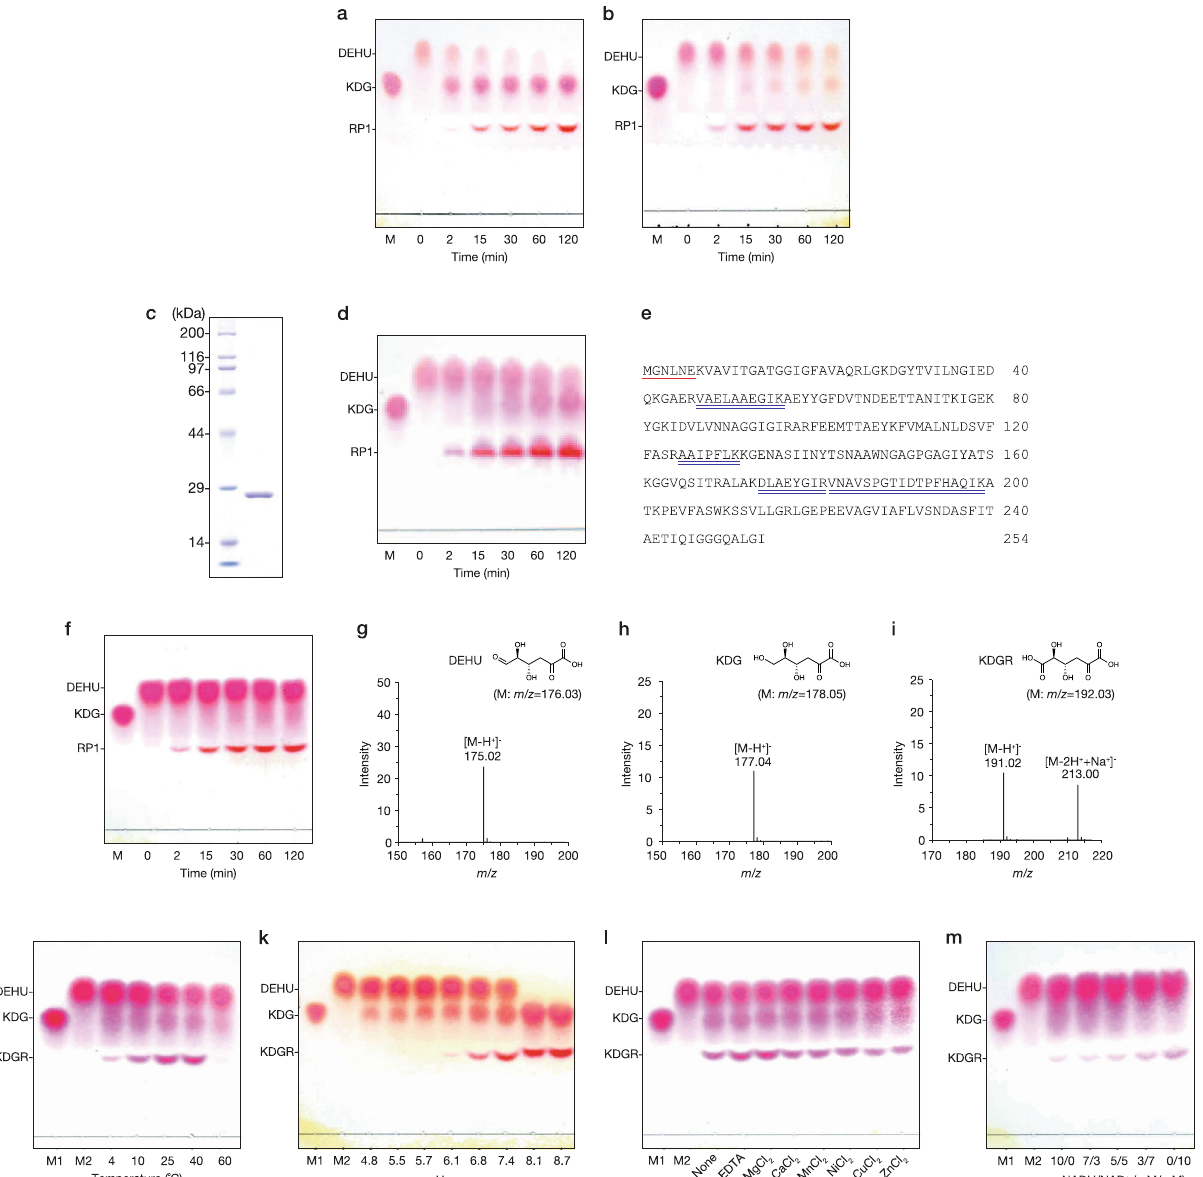
Fig. 1 Reduction and oxidation of DEHU. a , b TLC analysis of products in a mixture. Reaction was conducted in 10 mM sodium phosphate (pH 7.4), 100 mM KCl, 1 mM DTT, 0.5 mg mL − 1 cell extract, and 25 mM DEHU with 5 mM NADH ( a ) or NAD + ( b ) at 25 °C. M, KDG; RP1 , unknown reaction product 1. c SDS-PAGE of puri fi ed DEHU-oxidizing enzyme from cell extract. Left lane, protein marker; right lane, puri fi ed protein after gel fi ltration chromatography. d TLC analysis of a mixture containing 50 µ g mL − 1 puri fi ed protein (right lane of ( c )), 25 mM DEHU, and 5 mM NAD + . Reaction condition was same as